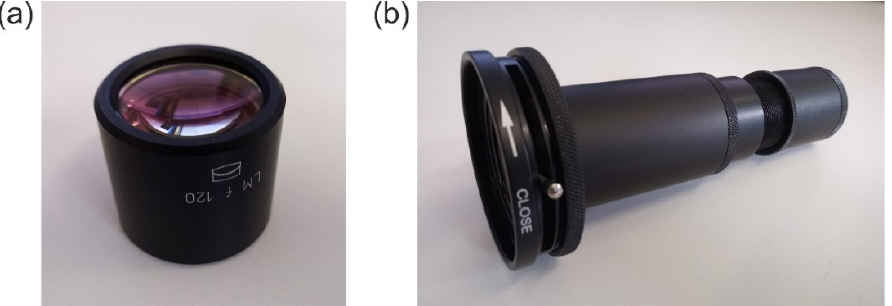
Figure 5. ( a ) Laser focusing optics LINOS 033486. ( b ) Opto-mechanical assembly built using a standard lens tube system for mounting the laser focusing optics to a camera device, with diaphragm at the optics entrance.